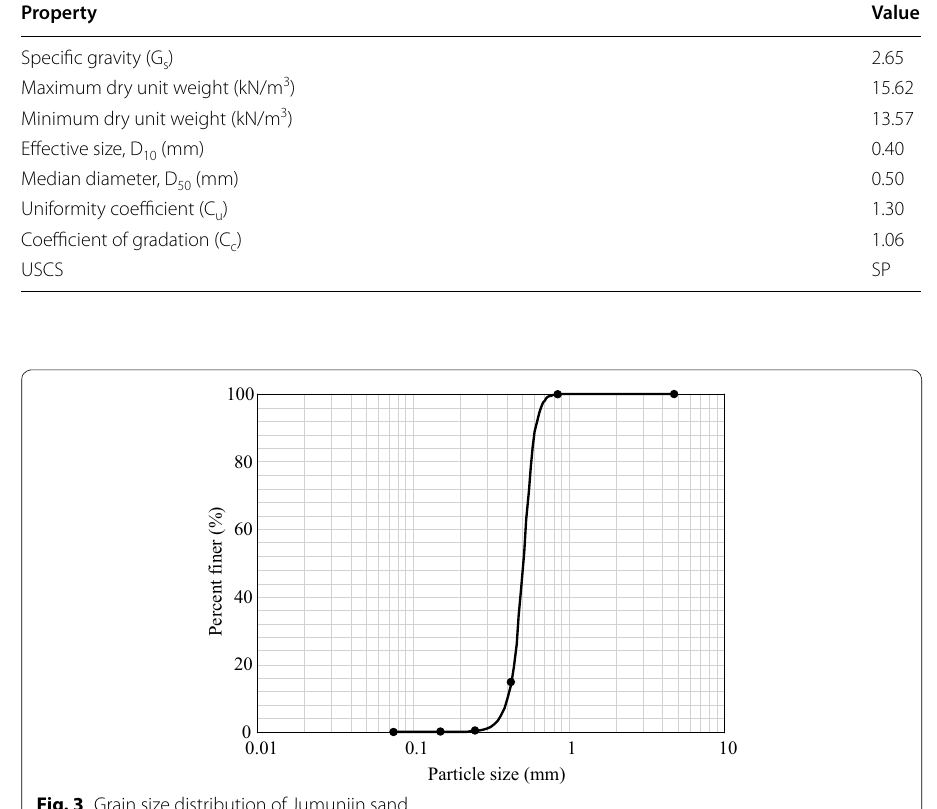
Fig. 3 Grain size distribution of Jumunjin sand